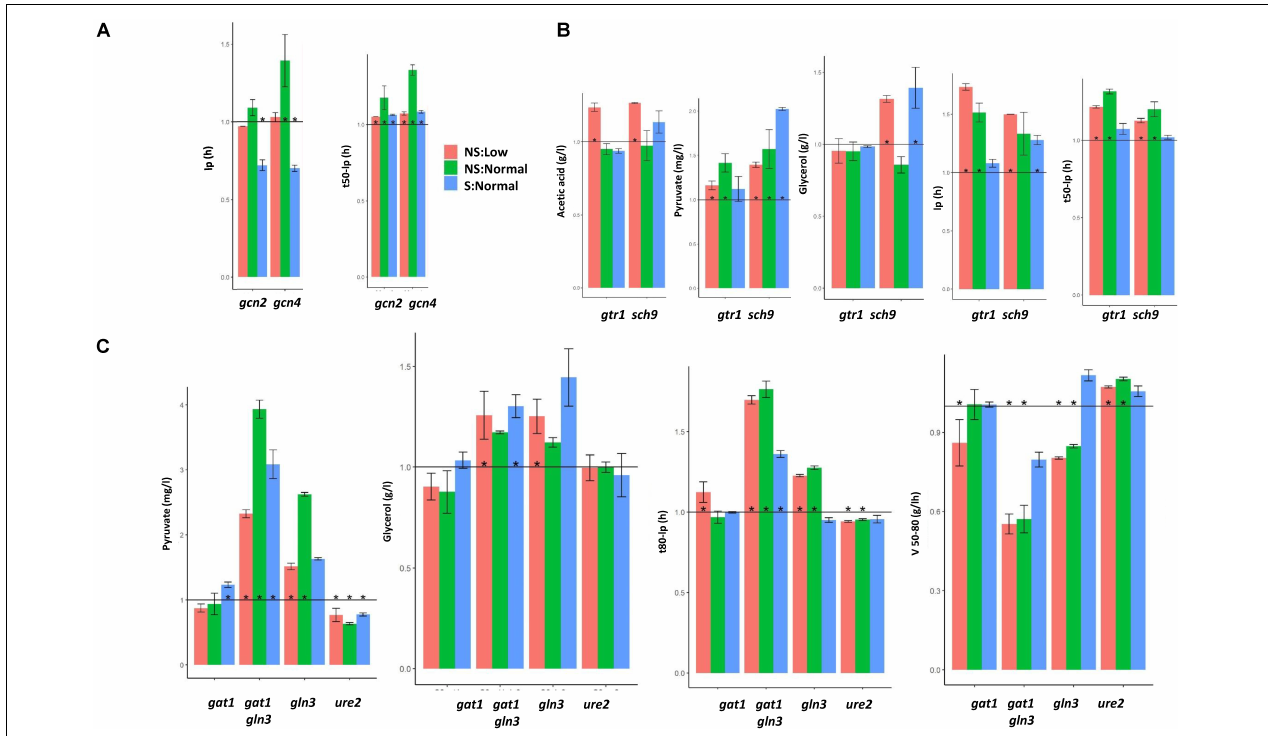
FIGURE 8 | The mutations on the different nutrient signaling pathways have their own phenotypic signature. (A) Parameters of interest in the mutations in genes GAAC, GCN2, and GCN4 . (B) The same for the components of TOR pathway GTR1 and SCH9 . (C) Similar analysis for NCR components GLN3 , GAT1, and URE2 . Fermentations were carried out in triplicate, and average and standard deviations are shown. Significant differences ( p < 0.05) are marked by